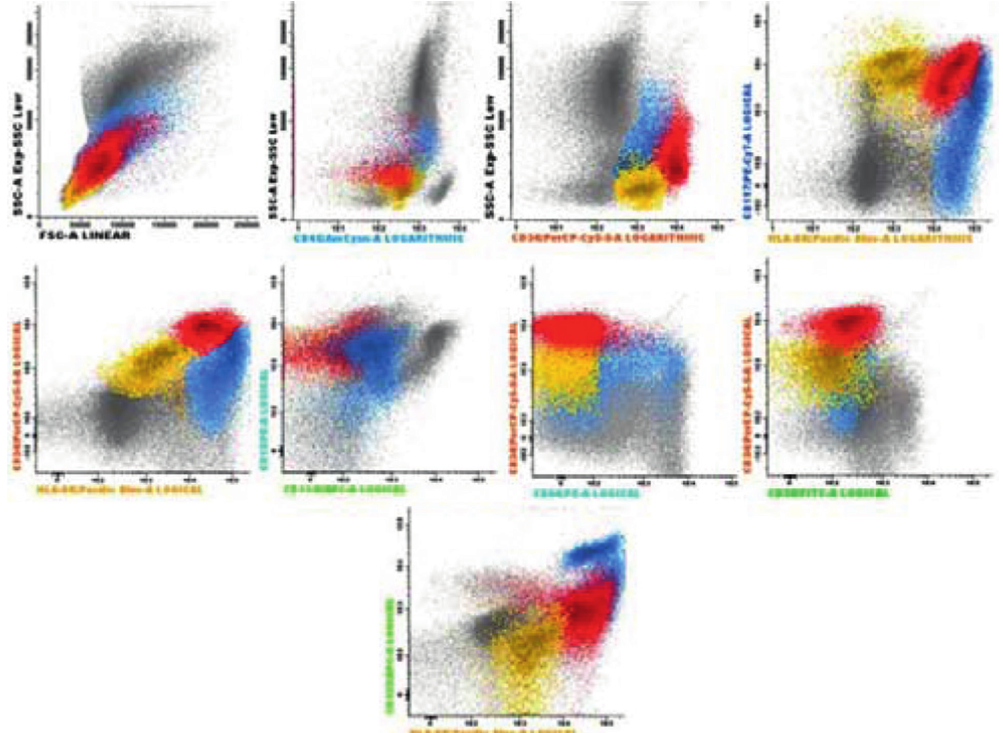
Figure 2: Flow cytometry at diagnosis showed 33% of blasts distributed in 3 populations. 1 st population, myeloid without differentiation (15%), in red: CD34++, CD117 +, HLA-DR+, CD45 +d, CD13+, CD64 − , CD35 − /+ d, CD36 − , CD33 +, CD71 − / +, CD105+ d, CD7 − / +, CD15 − / +, CD22 − , CD38 +, CD123+, CD4+d, and cMPO − . 2 nd population, dendritic (13%), in blue: CD34+d, CD117 − /+, HLA-DR++, CD45+d, CD13 +, CD64 − /+, CD35 − , CD36 − / +, CD33++, CD71 − /+, CD105 +d, CD7 − /+, CD15 − /+, CD22 − , CD38+, CD123++, CD4 +d, and cMPO − / +. 3 rd population, myeloid (5%), in yellow: CD34 +d, CD117 +d, HLA-DR − /+, CD45 +d, CD13+, CD64 − , CD35 − , CD36 − , CD33 − , CD71 − , CD105 − , CD7 − , CD15 − , CD22 +, CD38 − , CD123 − , CD4 − /+d, and cMPO − . Blasts were negative for CD10, CD16, CD11b, CD14, IREM-2, nTdT, CD56, CD19, 7.1, CD42, CD61, CD203c, cCD79a, cCD3, and CD3.